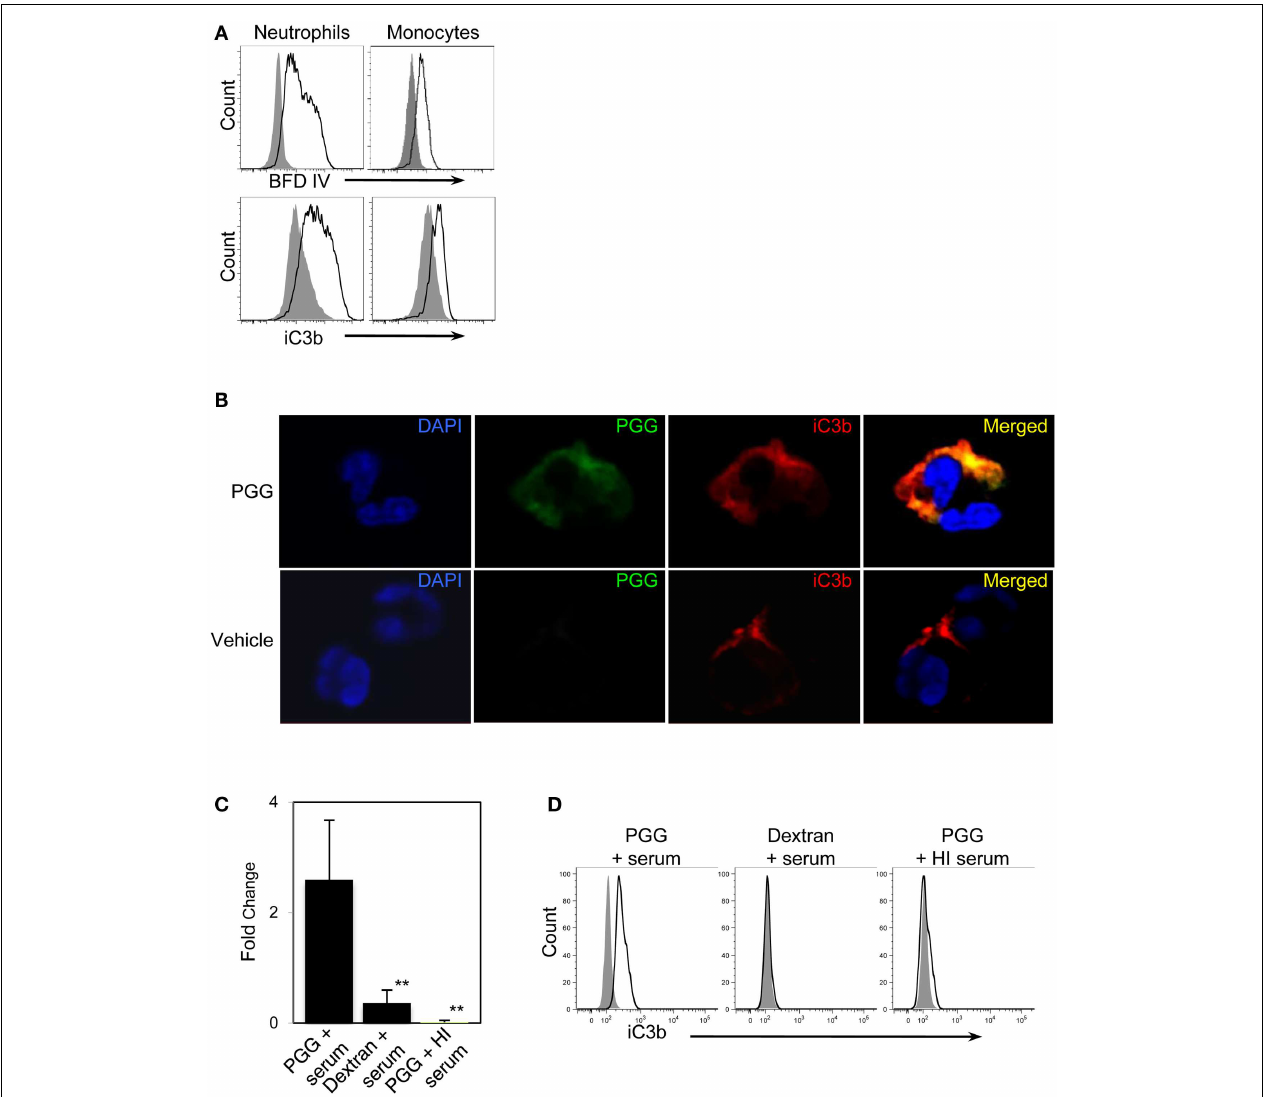
independent experiments. (C) Direct interaction of iC3b with immobilized PGG β -glucan in serum or HI serum was evaluated by ELISA. Dextran was used as control glucan. Bars represent mean fold change values from three independent experiments. ** p ≤ 0.05 compared with PGG β -glucan-treated with serum. (D) iC3b present in the immunoprecipitated PGG β -glucan-serum complex was detected by Flow Cytometry.The histogram shows the comparison of iC3b detected on the beads pulled-down from the various glucan-serum mixtures (solid) in comparison to that from the vehicle-serum mixture (gray filled). Data shown are representative of three independent